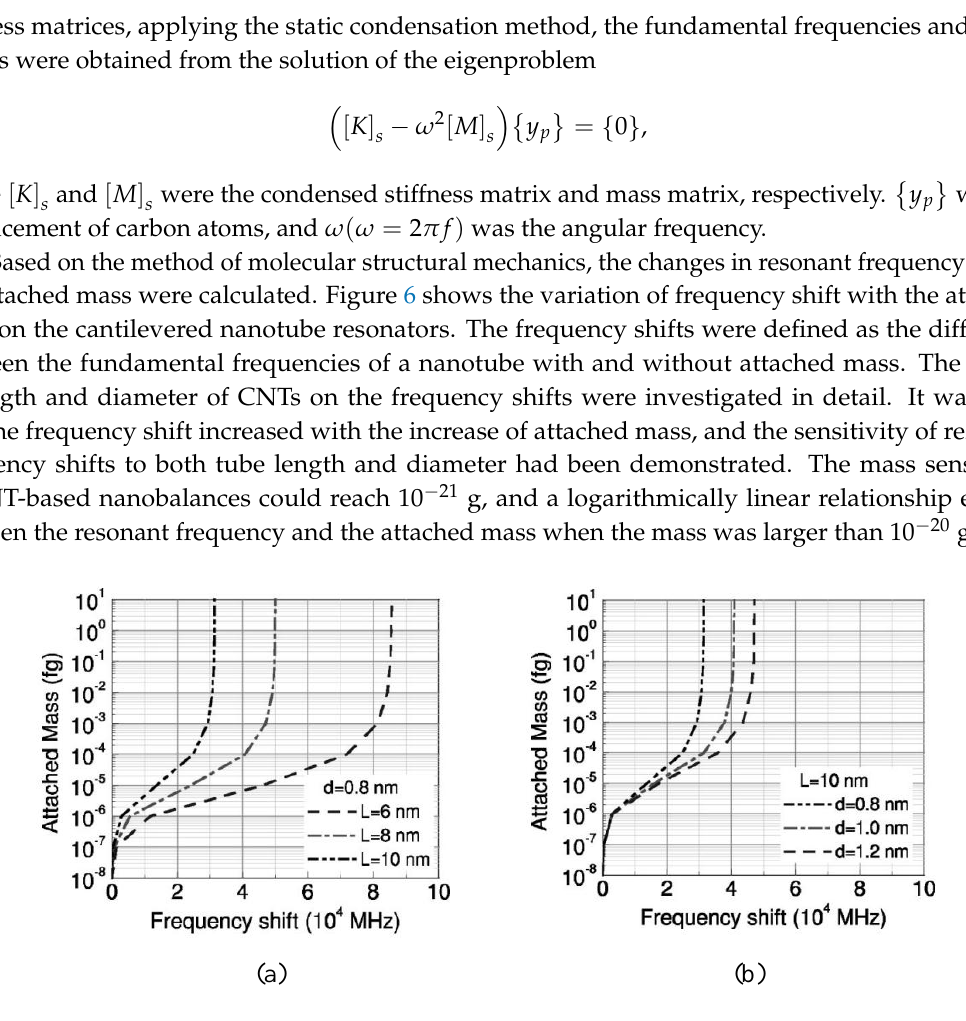
Figure 6. Resonant frequency shifts of cantilevered nanotubes with different lengths ( a ) and tube diameter ( b ) vs. attached mass. Adapted with permission from [37], Copyright AIP Publishing LLC, 2004.